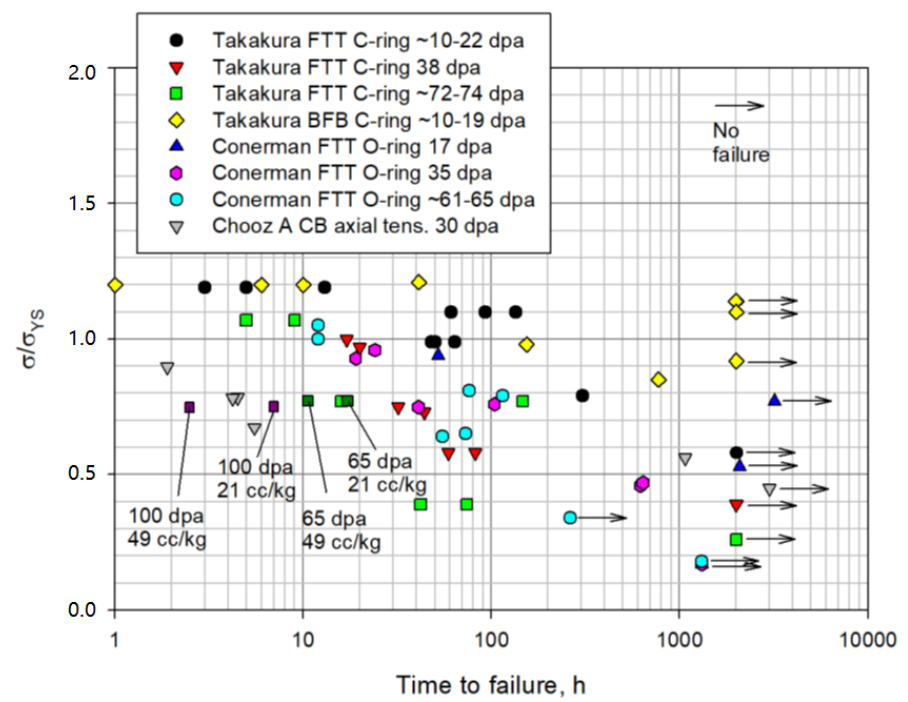
Figure 30. Literature data shown in Figure 3, but with the FTT results of the current study now included, along with their associated